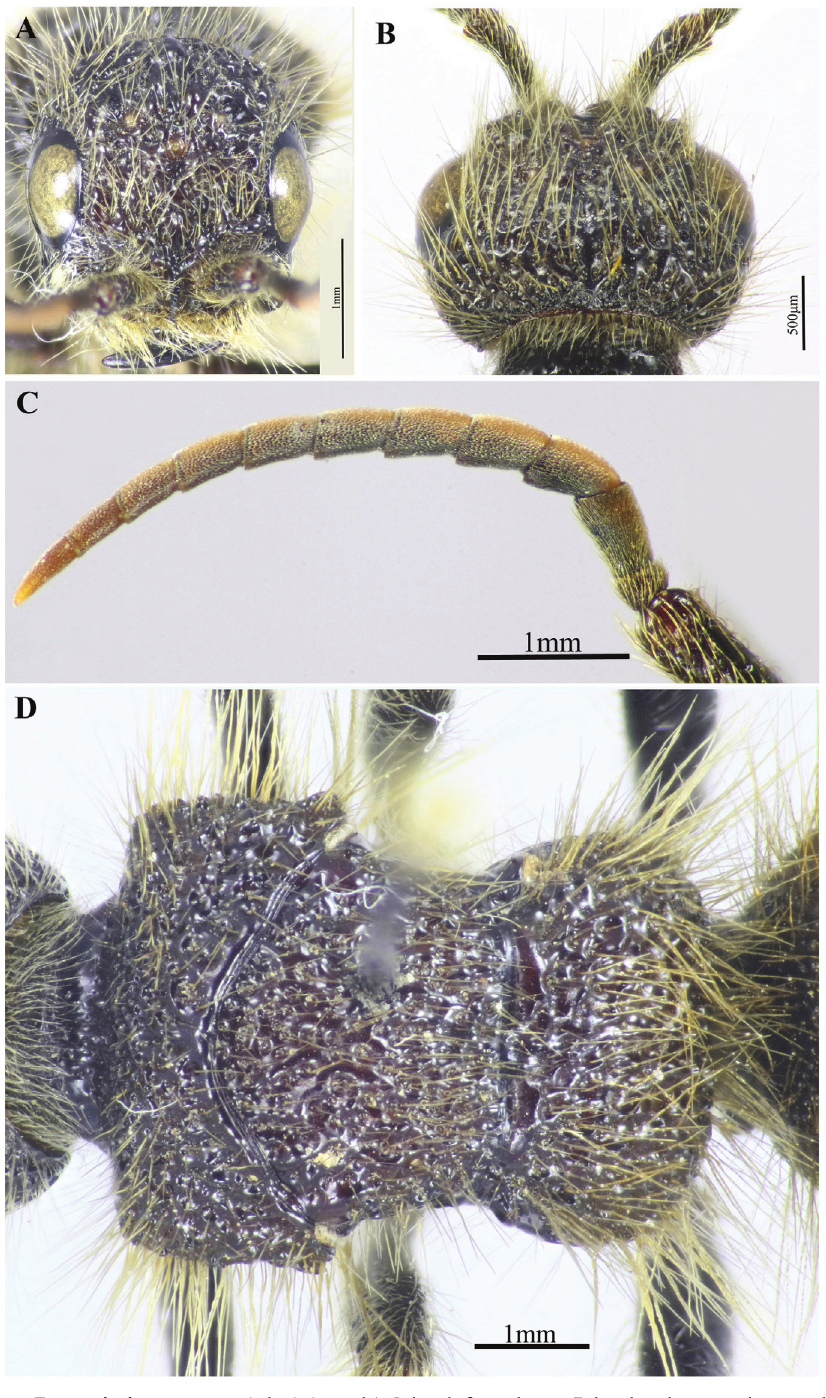
Figure 7. Pseudophotopsis aurea (Klug) (Female) A head, frontal view B head and antennal scape, dorsal view C antenna (with only part of scape) D mesosoma, dorsal